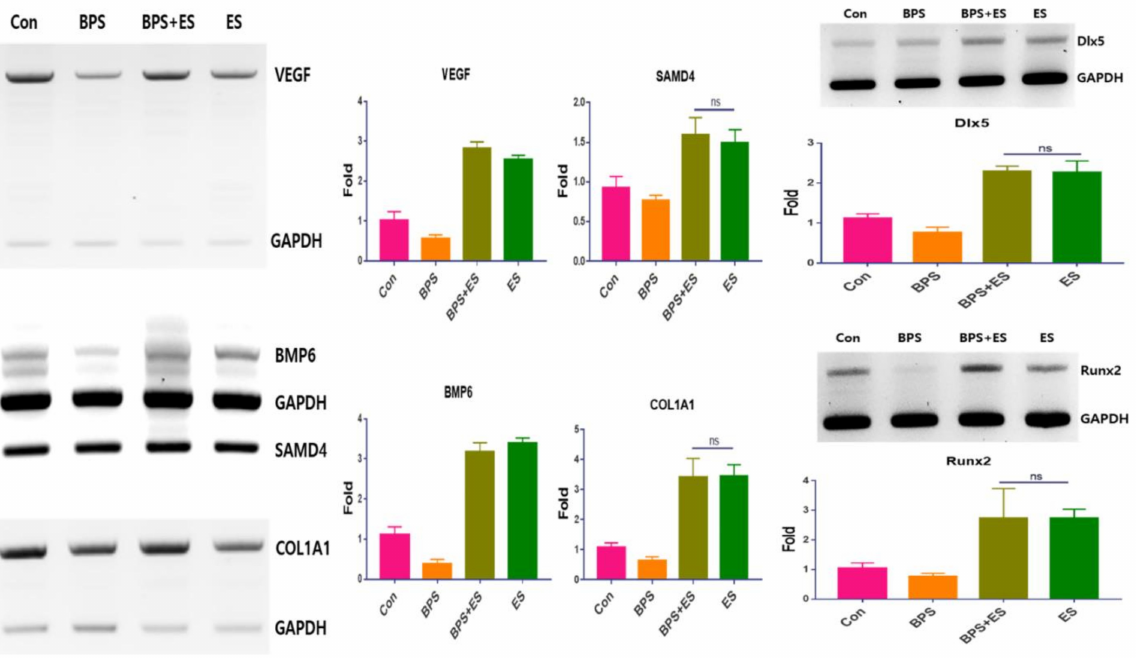
Figure 4. Expression of osteogenic genes in adipose-derived stem cells (ASCs) exposed to conditioned media. Bands indicating cDNA levels for the osteogenic markers. Histograms indicating relative fold changes for the corresponding intensity levels. BPS+Ext represents that ASCs were exposed to the conditioned medium after treatment using black jade extract (Ext). The conditioned medium (BPS) contained the supernatant from the fibroblast cells exposed to benzo(a)pyrene. The conditioned medium (ES) contained the supernatant from the fibroblast cells exposed to the extract. Con; Control, ( p < 0.05, n = 3). BPS: benzo(a)pyrene inducing supernatants; ES: extract